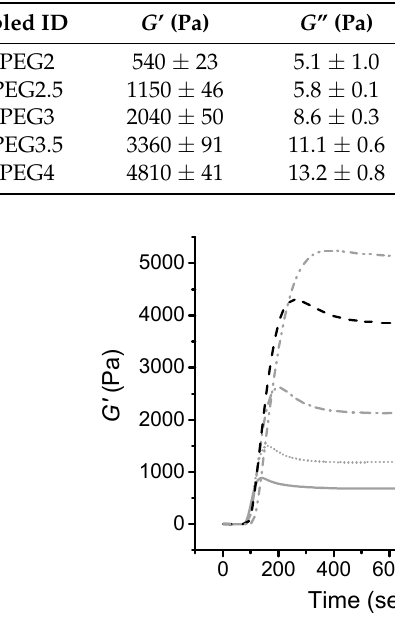
Figure 4. Curing time sweep measurements of thiol-ene collagen mixtures prepared with 0.5% ( w / v ) LAP and varied PEG content. CollPEG2: ( ⎯ ); CollPEG2.5: ( ⋅⋅⋅ ); CollPEG3: ( - ⋅ - ); CollPEG3.5: ( - - ); CollPEG4: ( - ⋅⋅ - ).